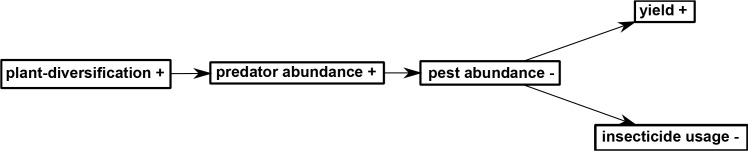
A path diagram depicting the hypothesis on the relationships among the variables considered in this study.‘+' indicates increased level and '-' indicates decreased level.